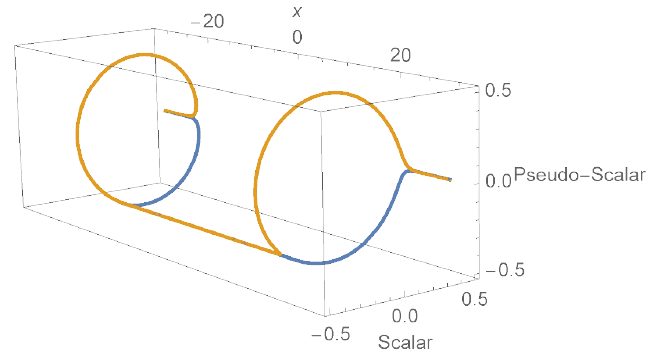
Figure 1 . Position dependence of the scalar condensate S ( x ) and pseudo-scalar condensate P ( x ) in the massless charge- 3 Schwinger model with the charge- q p Wilson loop. We set g = 1 , θ = 0 and put the Wilson loop at x = ± 20 (i.e. L = 40 ). The yellow and blue curves denote the cases for the probe charges q p = 2 and q p = − 1 ,